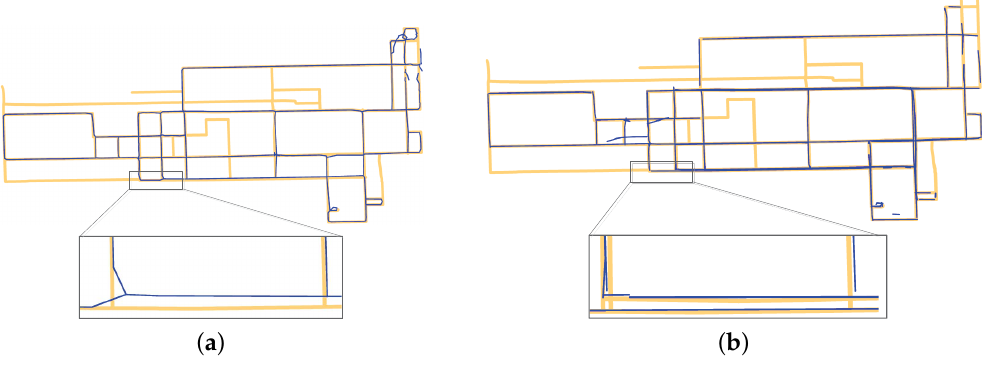
Figure 7. Comparison of Biagioni and Eriksson’s method and our method on the Chicago dataset. ( a ) Generated road map (blue lines) with Biagioni and Eriksson’s method and the road network actually visited by vehicles (yellow lines); ( b ) generated road map (blue lines) with the proposed method and the road network actually visited by vehicles (yellow